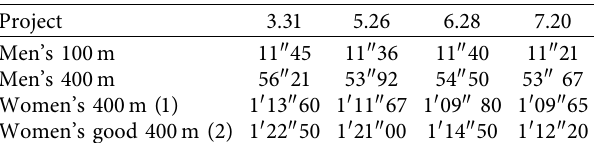
Table 6: Statistical table of changes in sports performance of 4 athletes.